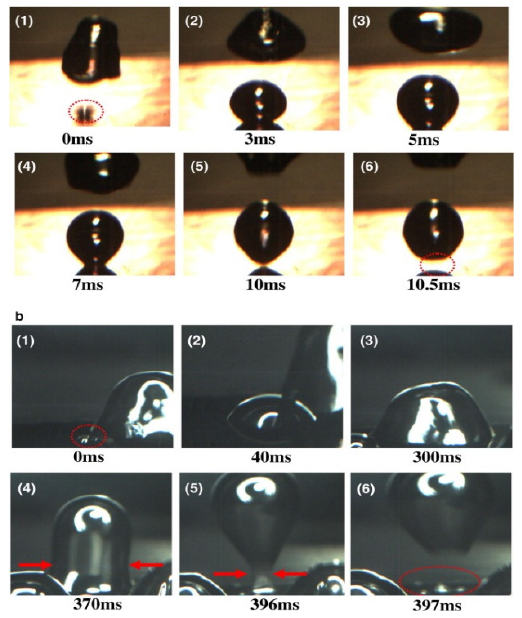
Figure 12. Generation process of bubbles: ( a ) hydrophilic surface; ( b ) hydrophobic surface [71].